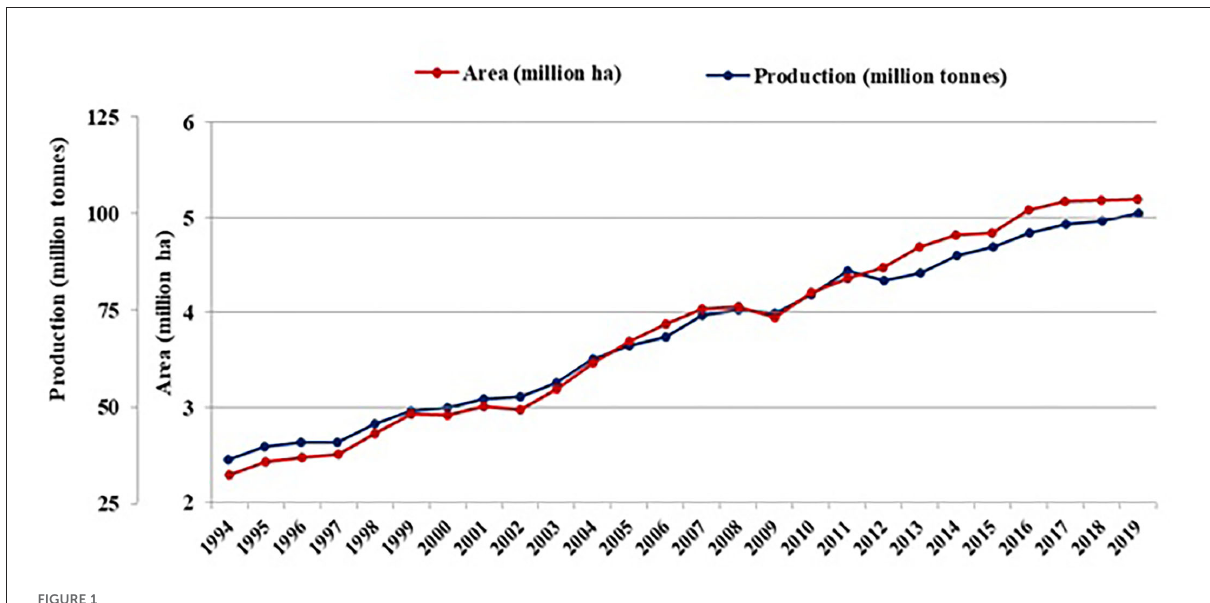
FIGURE1 World status of onion on area harvested and production (Source: FAOSTAT,